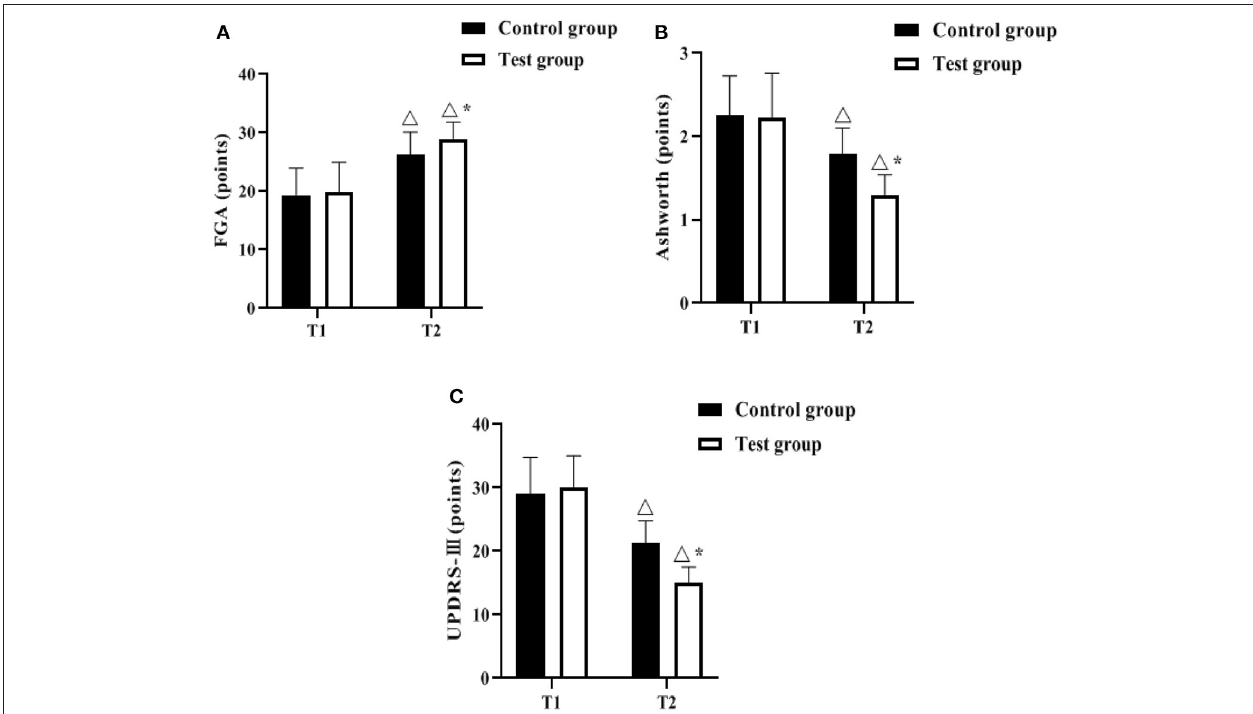
FIGURE 2 | Comparison of movement symptoms ( n , x ± s). (A–C) indicate the FGA, Ashworth and UPDRS-III scales, respectively. Icon 1 indicates the difference between T2 period and T1 period between the same groups, P < 0.05. Icon * indicates the difference between the two groups in T2 period, P <